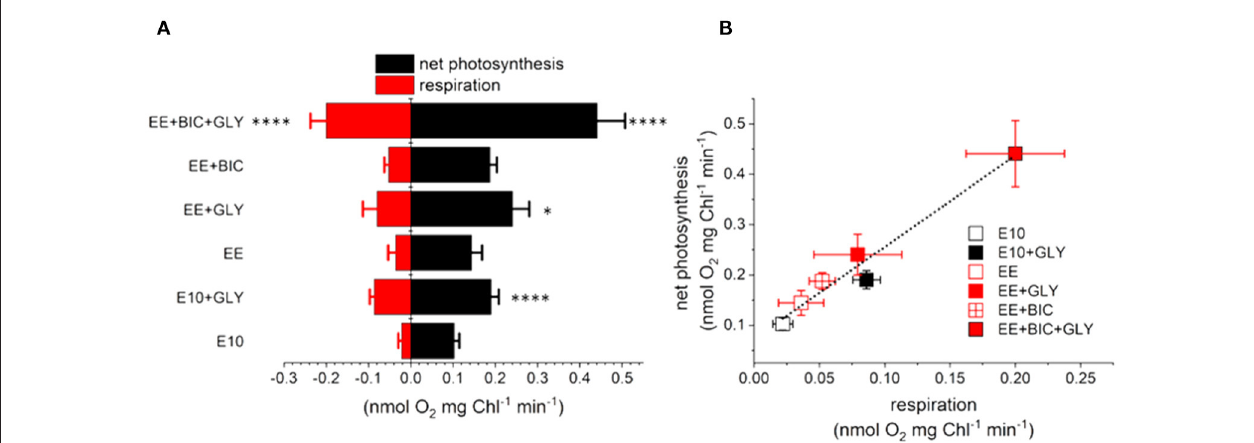
FIGURE 4 | (A) Direct assessment of oxygen consumption/production by a polarographic approach in E10, EE, and EE + BIC in both phototrophy and mixotrophy (+GLY). Measurements were done in the light (i.e., photosynthesis, black) and in the dark (i.e., respiration, red). One-way analysis of variance (ANOVA) test was applied in order to compare the phototrophy and mixotrophy in different media. Data were considered significant for p -values < 0.1 (**** p < 0.0001, * p < 0.1). (B) Relationship between oxygen uptake and net photosynthesis measured with a Clark electrode. Dotted lines represent a fitted regression. Each point expressed as mean ± stdev ( n =